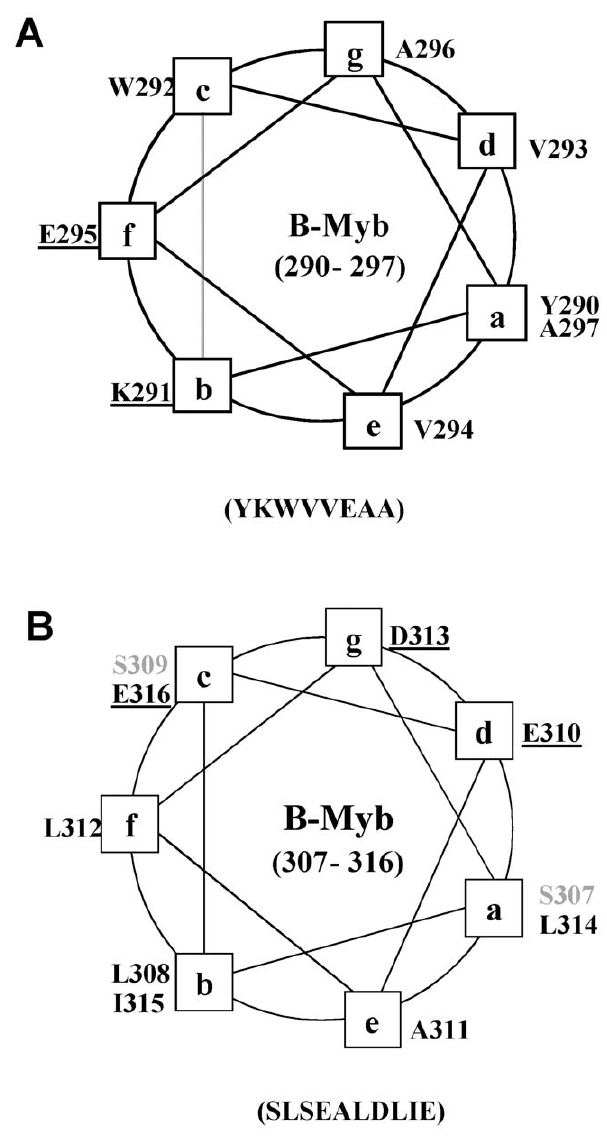
Figure 6. Potential amphipathic helices in the B-Myb TAD. Panels A and B show helical wheel representations of the regions of the B-Myb TAD predicted to form amphipathic helices, charged residues are underlined and polar residues shown in italics. The positions of the helical regions were predicted using the programme PSIPRED [71], [72].